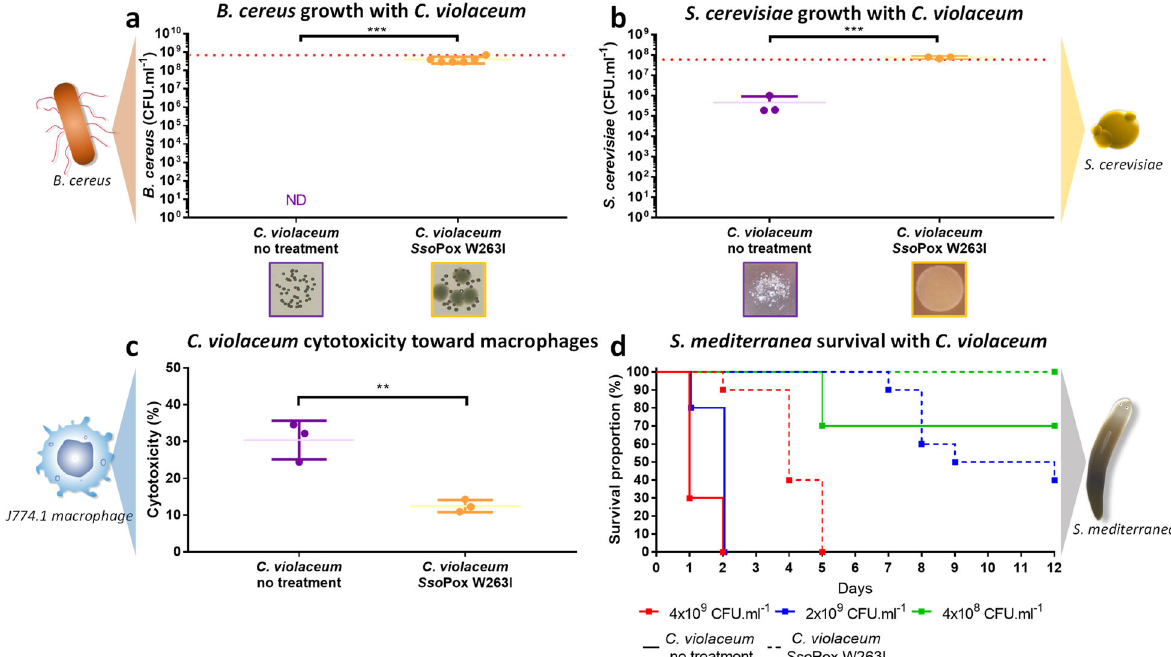
Fig. 8 Sso Pox alters C. violaceum interaction with prokaryotic and eukaryotic organisms. a Mean bacterial concentration in CFU ml − 1 of B. cereus after 8 h of cocultures with C. violaceum treated with 0.5 mg ml − 1 Sso Pox W263I (yellow) and untreated cultures as negative controls (purple). Error bars represent the standard deviations of n = 6 experiments (three biological replicates × two technical replicates). The dotted red line represents the mean bacterial concentration of B. cereus monoculture. Representative pictures of dilution on LB-Agar plate (dilution factor at 10 − 6 ) of B. cereus cultures with treated cultures of C. violaceum with 0.5 mg ml − 1 Sso Pox W263I (yellow square) and untreated cultures as negative controls (purple square) are given. *** P values <0.001 according to the Student ’ s t test. ND not detected. b Mean yeast concentration in CFU ml − 1 of S. cerevisiae after 24 h growth on YPD-Agar infected by C. violaceum treated with 0.5 mg ml − 1 Sso Pox W263I (yellow) and untreated as negative controls (purple). Error bars represent the standard deviations of n = 3 biological replicates. The dotted red line represents the mean yeast concentration of S. cerevisiae on non-infected YPD-Agar. Representative pictures of dilution on YPD-Agar plate (dilution factor at 10 − 2 ) of S. cerevisiae growth on the plate infected by treated cultures of C. violaceum with 0.5 mg ml − 1 Sso Pox W263I (yellow square) and untreated cultures as negative controls (purple square) are given. *** P values <0.001 according to Student ’ s t test. ND not detected. c Cytotoxicity of C. violaceum toward J774.1 macrophages with 0.5 mg ml − 1 Sso Pox W263I (yellow) or untreated as negative controls (purple) during a 1.5 h infection at a MOI of 1. Error bars represent the standard deviations of n = 3 replicated experiments. ** P values <0.01 according to Student ’ s t test. d Planarian survival in the presence of C. violaceum treated with 0.5 mg ml − 1 Sso Pox W263I (dotted line) and untreated cultures as negative controls (full line) at 4 × 10 9 CFU ml − 1 (red), 2 × 10 9 CFU ml − 1 (blue), 4 × 10 8 CFU ml − 1 (green). Curves represent survival proportions of ten planarians. According to log-rank (Mantel – Cox) test comparing survival curves in treated and untreated conditions P values <0.0001 for 4 × 10 9 CFU ml − 1 and 2 × 10 9 CFU ml − 1 conditions and P value = 0.0671 for 4 × 10 8 CFU ml − 1